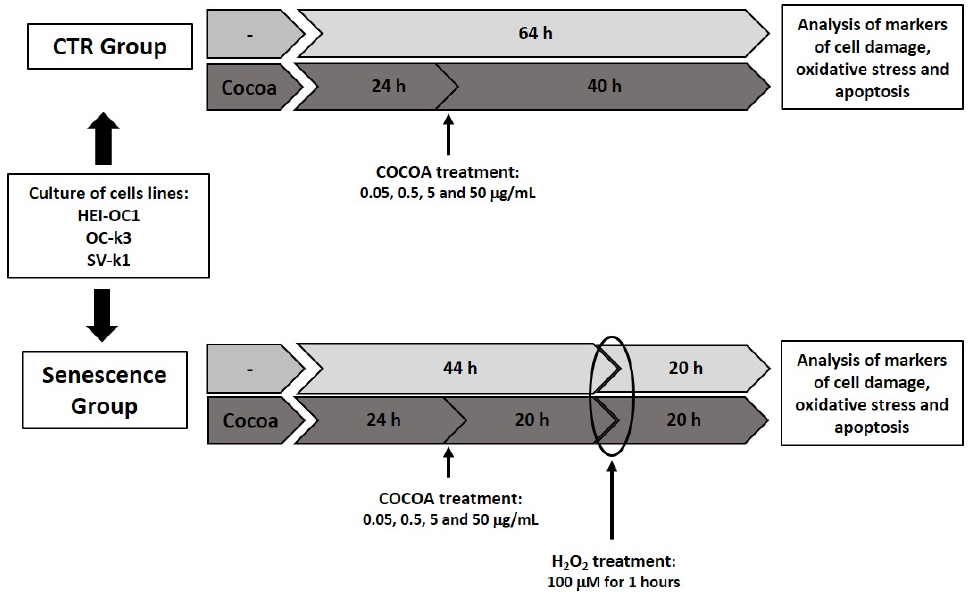
Figure 1. Comprehensive overview of the experimental timeline and procedures.